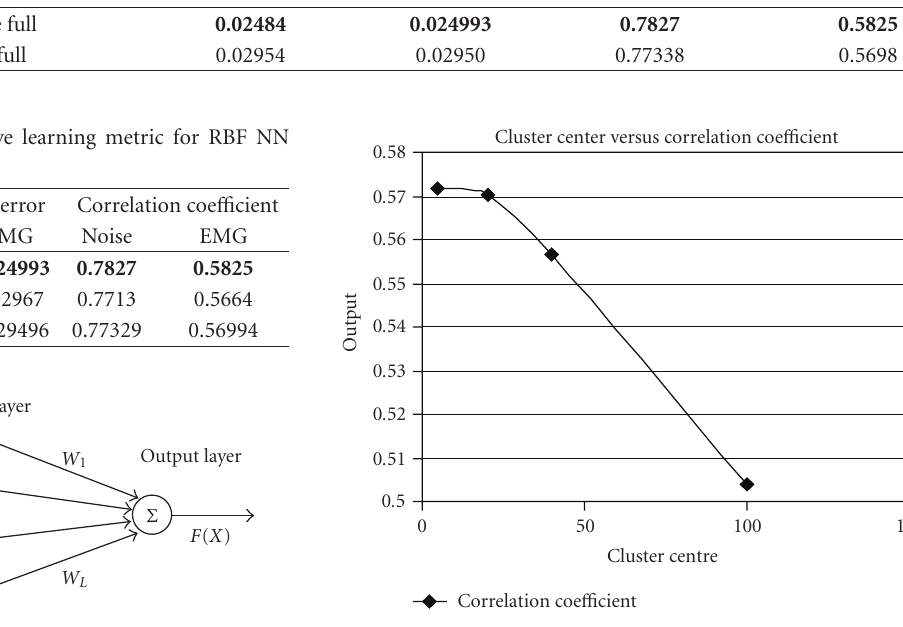
Figure 12: Radial basis function (RBF) network. Figure 13: Variation of correlation coe ffi cient for optimal number of cluster centers for RBF NN model.